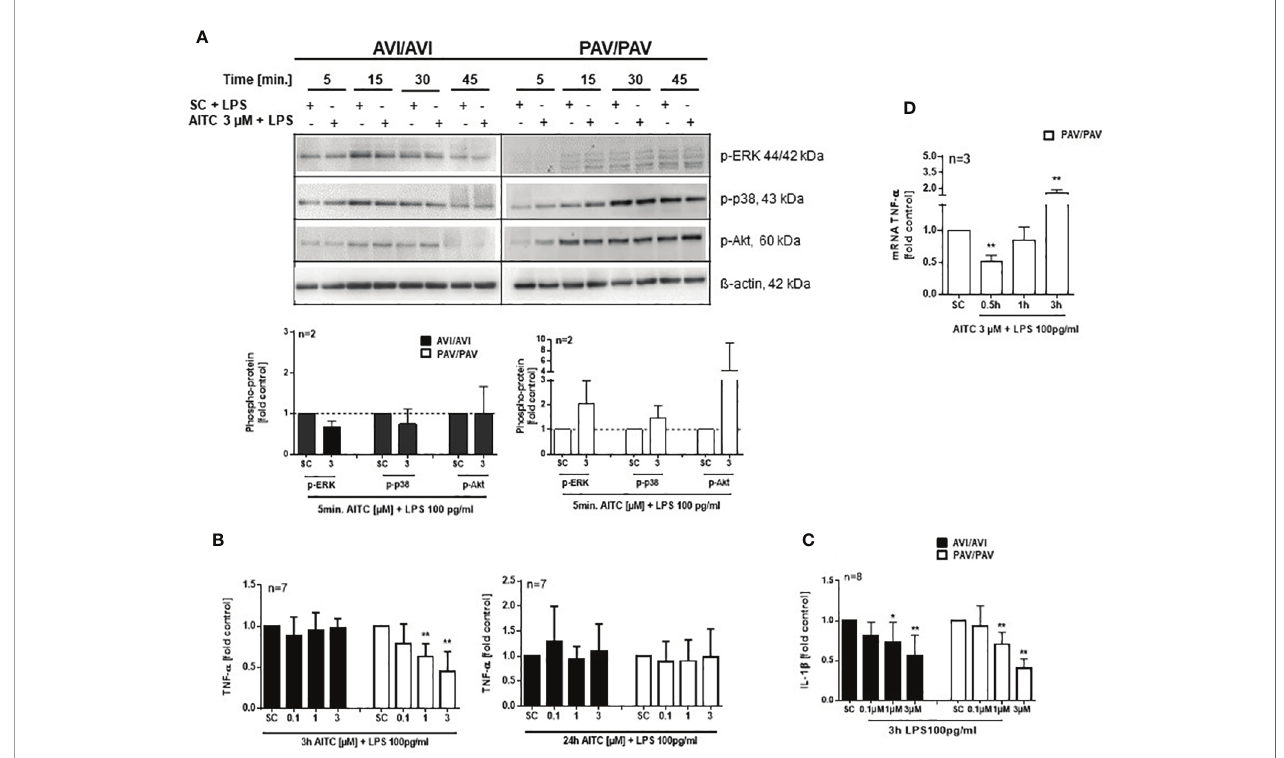
FIGURE 5 | In bacterial LPS stimulated PBMC, AITC triggers MAPK activation and TNF- a inhibition in dependence of the TAS2R38 genotype. PBMC were exposed to AITC or 0.01% DMSO (SC) together with 100 pg/mL LPS. (A) Representative immunoblots are given. Densitometric analysis was done to quantify the immunoblots using Quantity One software (Bio-Rad, Munich, Germany) and normalized against b -actin, which was used as loading control. (B , C) Cytokine secretion at 3 and 24 h was analyzed using ELISA kits. (D) Time kinetic of TNF- a mRNA expression. Results are means + SD and given as fold of the solvent control. Results were calculated relative to the corresponding solvent control (SC, 0.01% DMSO). Signi fi cance of difference was determined compared to the respective SC by one- way ANOVA, *p<0.05, **p<0.01.